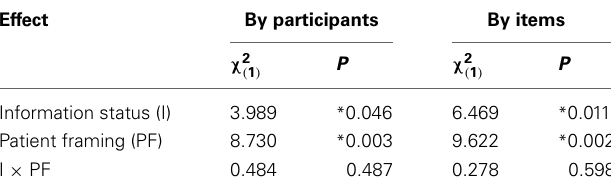
Table 7 | Generalized-Score Chi-Squares from binary logistic GEE analyses, predicting the likelihood of passive-voice responses by factor combinations of Information Status (given Agent or given Patient) and Patient Framing (Agent-like or Patient-like).